Question: Write the caption for this figure.
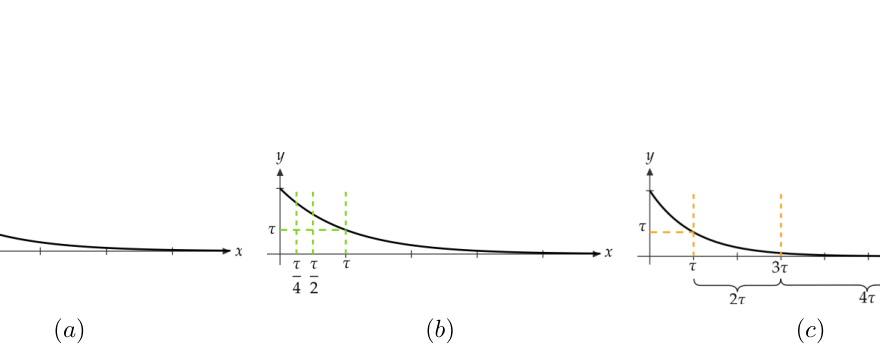
Answer: Proposals for boundary layer thickness for the simple function y “ e´x showing the thicknesses for L “ 3 layers of elements in terms of the non-dimensional skin depth τ being for paq “uniform” distribution, pbq “geometric decreasing” distribution, and pcq “geometric increasing” distribution.